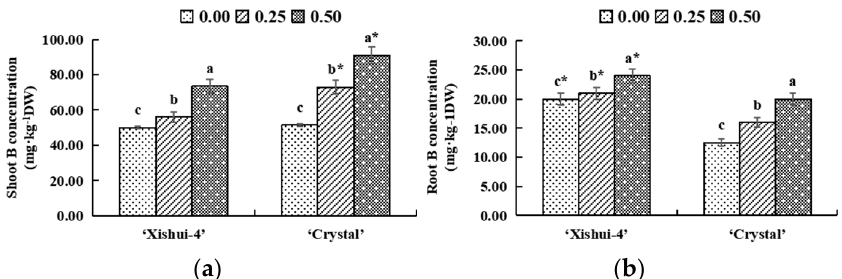
Figure 2. Effects of B-deficiency on B concentration of two grape genotypes: ( a ) shoot; ( b ) root. Dif- ferent lowercase letters within each column are significantly different at p < 0.05 between